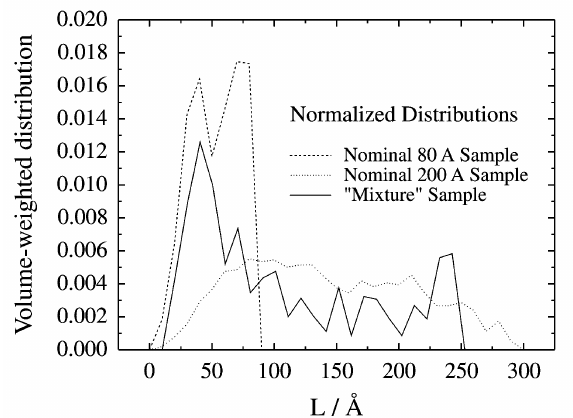
Figure 4. Volume-weighted distributions as a function of crystallite sizes for the three samples.